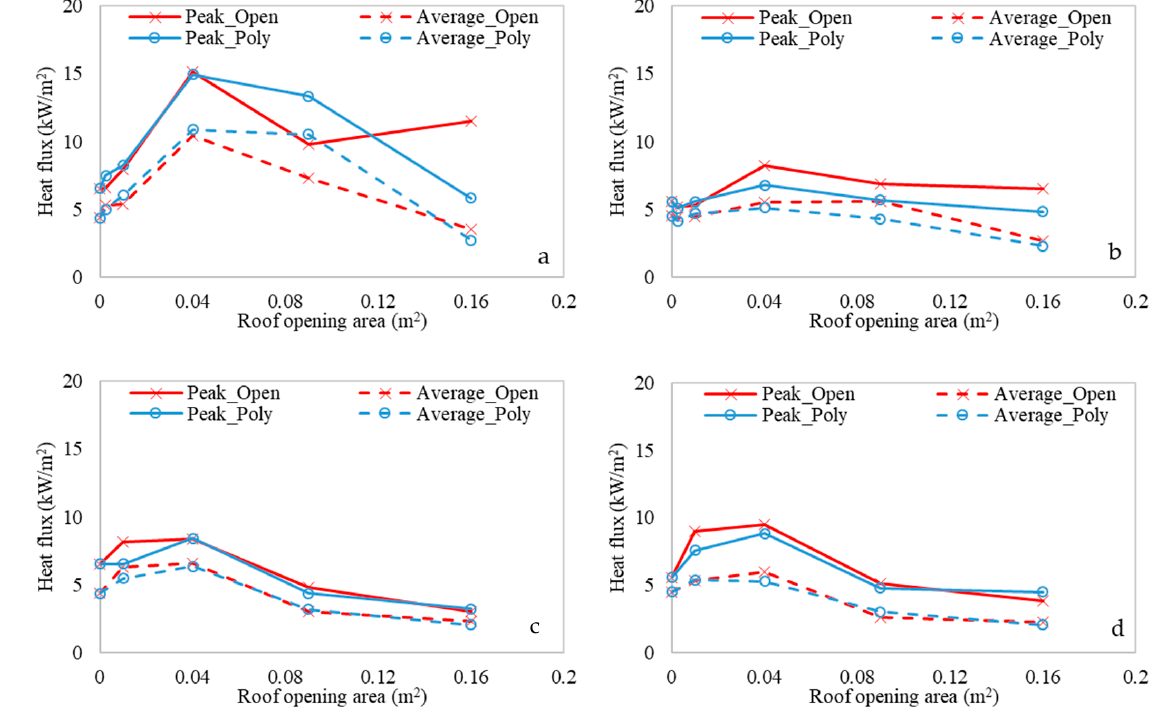
Figure 15. Peak and average heat flux in the steady-state phase at 15 cm for the following opening-wall combinations: ( a ) corner-back, ( b ) corner-side, ( c ) slot-back, and ( d ) slot-side.